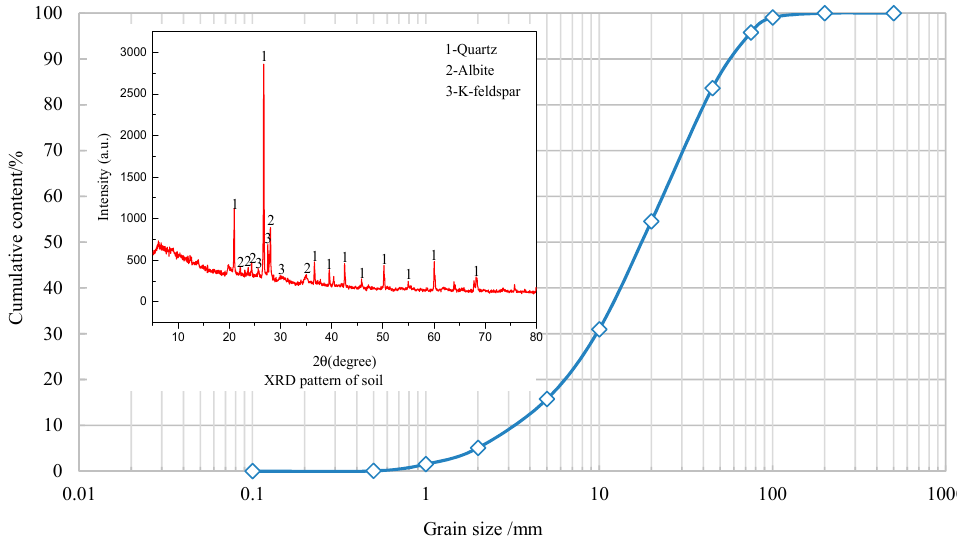
Figure 2. Soil sample from the undisturbed soil in the half-face pile test.